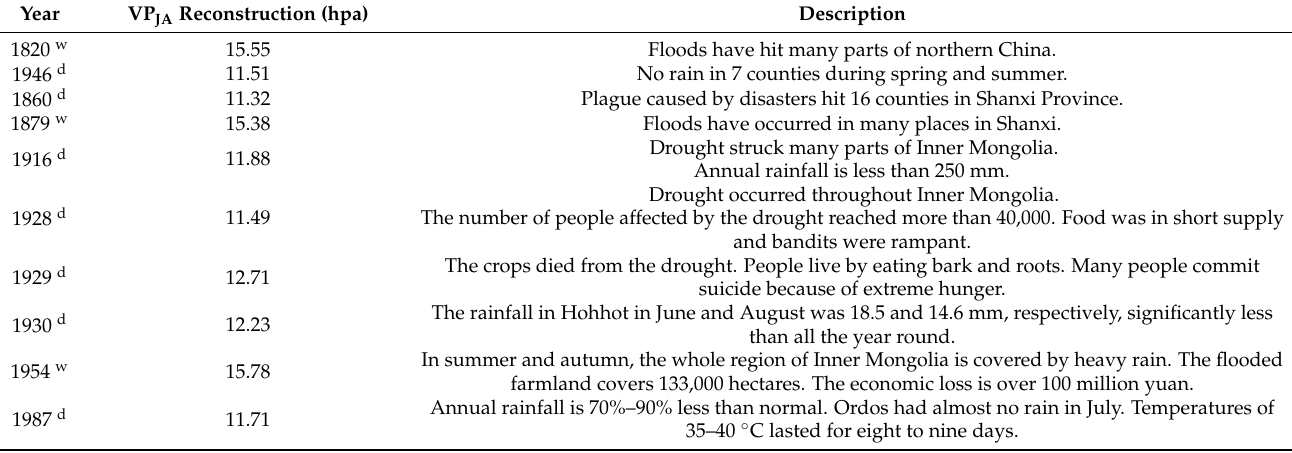
Table 3. Comparison between reconstructed VP JA and local historical